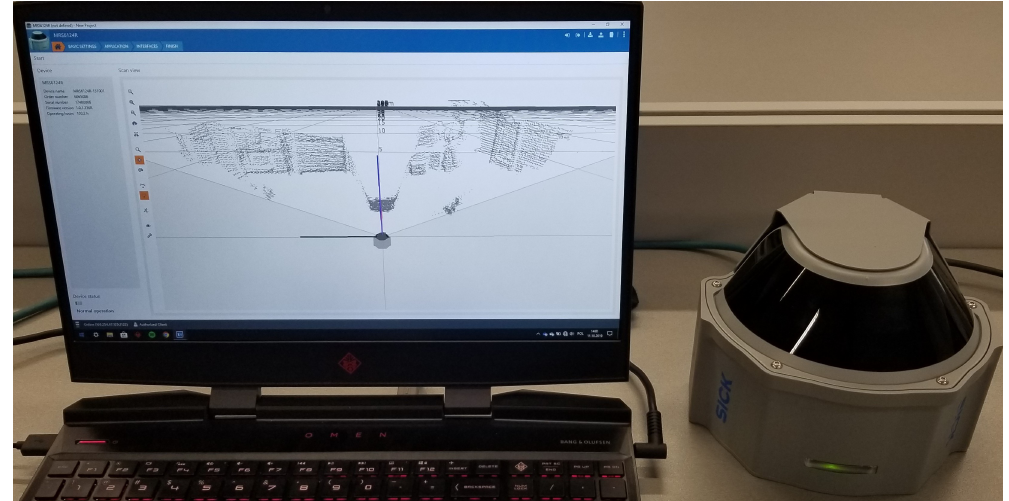
Figure 15. MRS 6000 range of scanning. Source: https://cdn.sick.com.